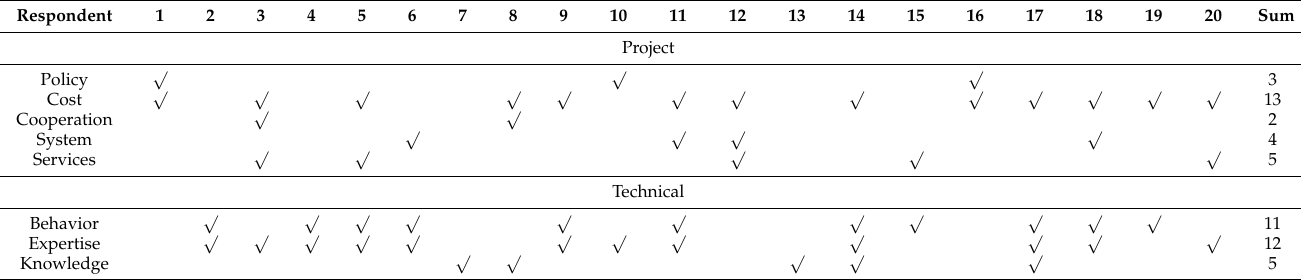
Figure 3. Summary of factors affecting trust in BIM-based construction projects. Table 3. Factors affecting trust in BIM-based construction projects.